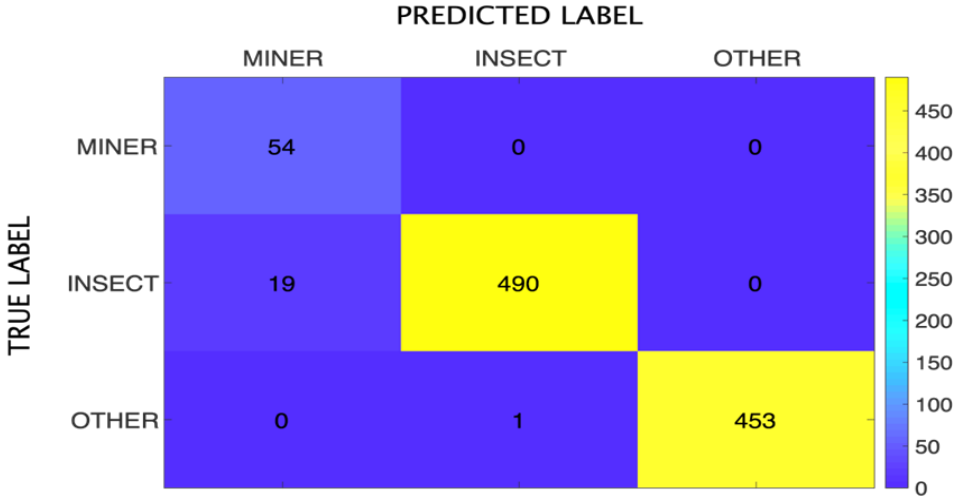
Figure 11. Confusion matrix of the detection algorithm for the Pest Monitoring Device (PMD).